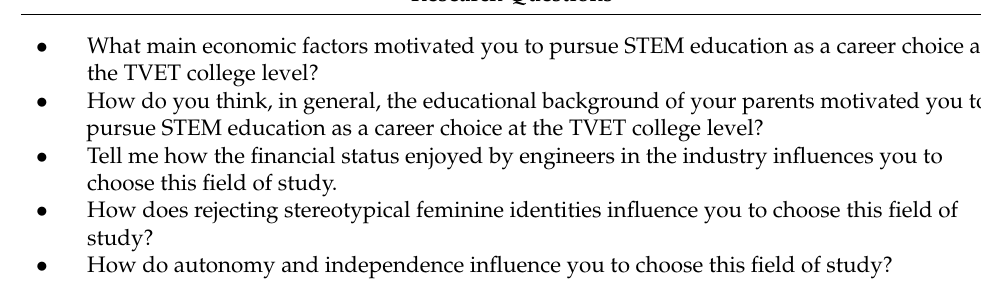
Table 1. Focus group interview